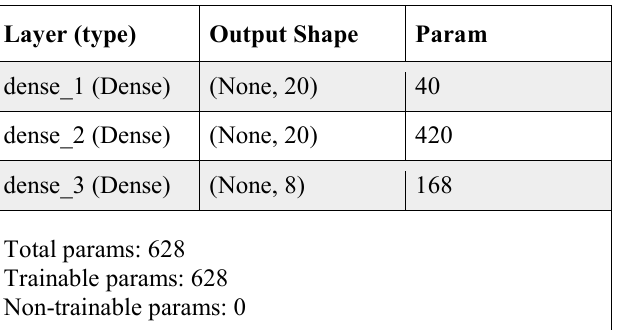
Table 1. Structure of adopted Multi-Layer Neural Network